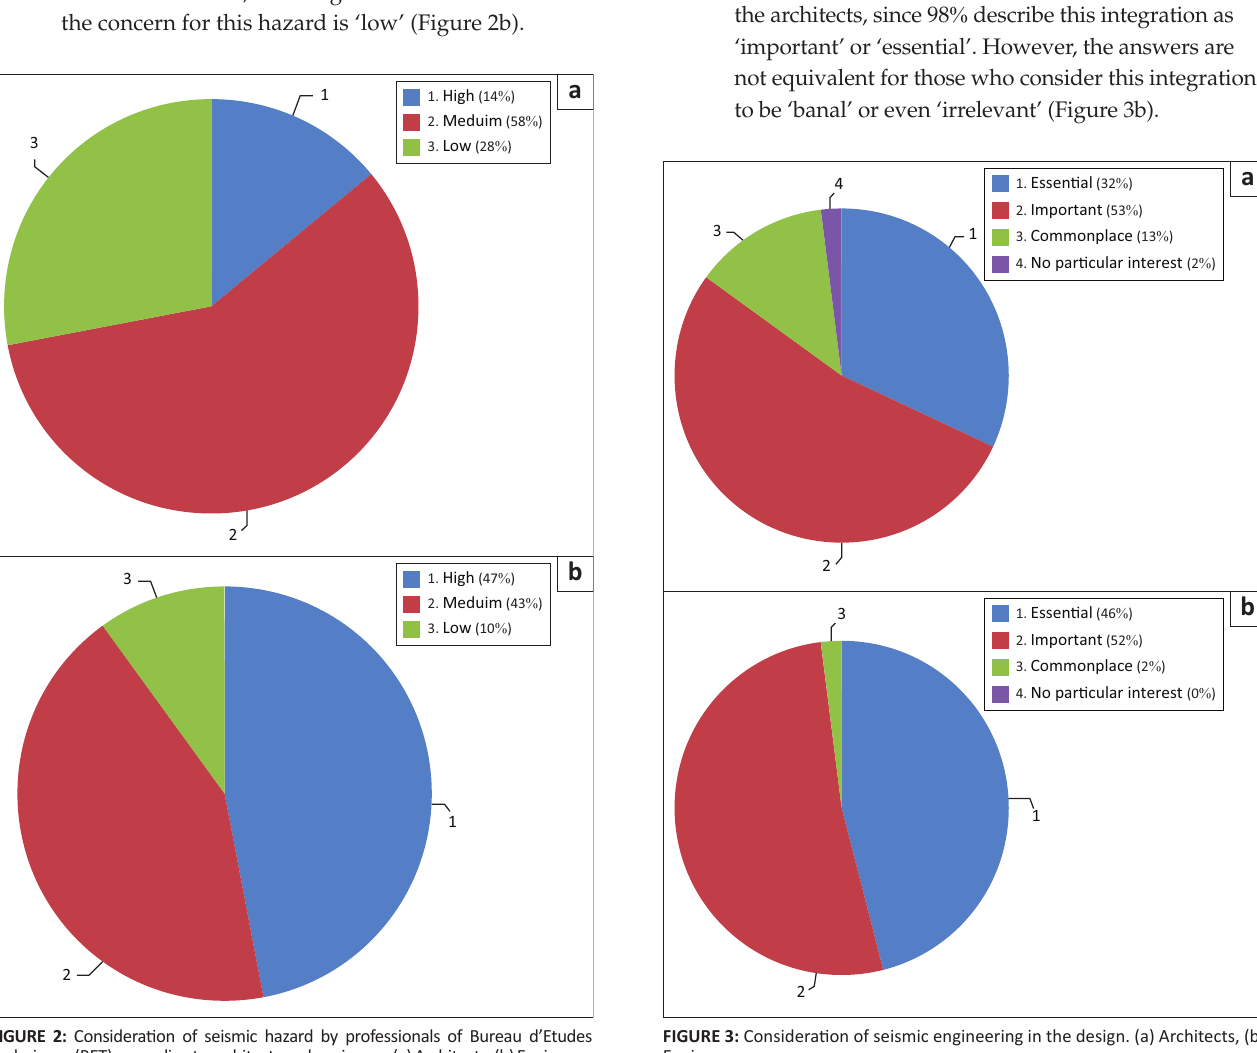
FIGURE 3: Consideration of seismic engineering in the design. (a) Architects, (b) Engineers.